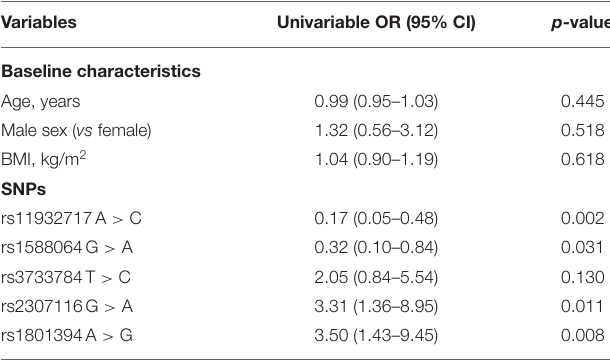
TABLE 4 | Univariable logistic regression analysis of preoperative variables and SNPs for predicting the susceptibility to agitation ( n = 176).